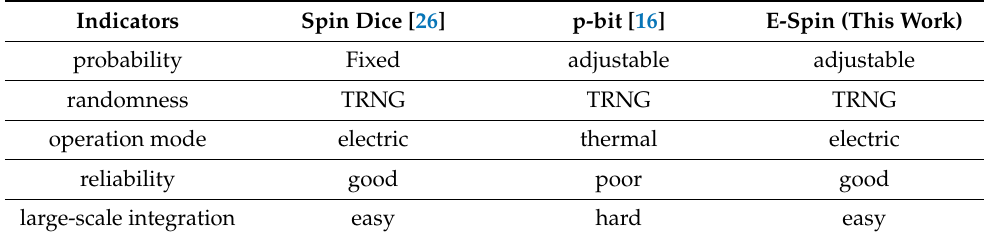
Table 1. Characteristics of the three random sources.